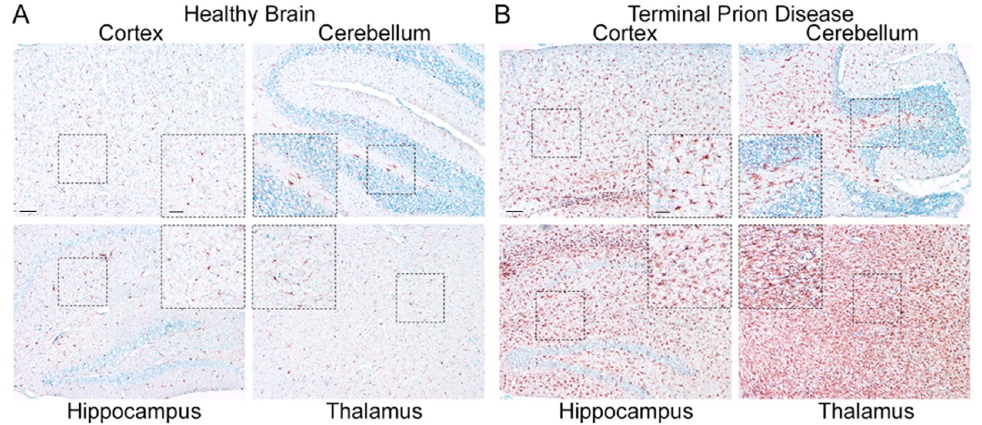
Figure 3. Microglia are highly activated in terminal prion disease. The pan-microglia/macrophage marker IBA1 is shown in mouse brain sections of ( A ) mock-infected healthy mice and ( B ) RML 5.0 prion-infected mice at a terminal disease state. ( A ) Microglia in the healthy brain show a ramified phenotype with a small soma and thin processes in all four regions displayed here (see magnified close-up). ( B ) During the terminal prion disease stage, microglia massively proliferate (see overview) and change their morphology towards bigger cell bodies and thicker arms (see close-ups) with a bushy appearance in the hippocampus and an amoeboid phenotype in the thalamus [45–47]. Scale bar: 100 µm; close-up: 50 µm.